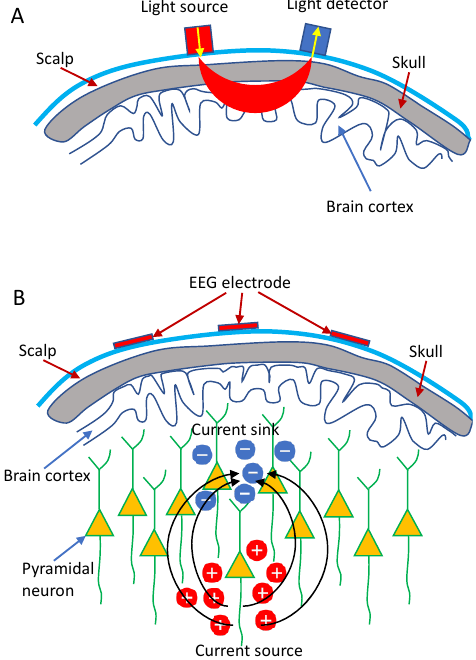
Figure 1. Schematic demonstration: ( A ) fNIRS and ( B ) EEG measurement.